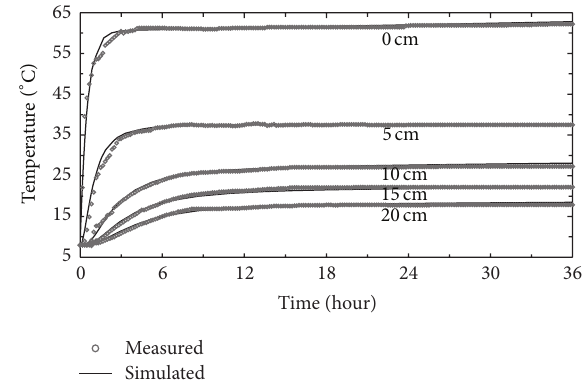
Figure 2: Temporal changes in simulated and measured soil temp- eratures at different depths.